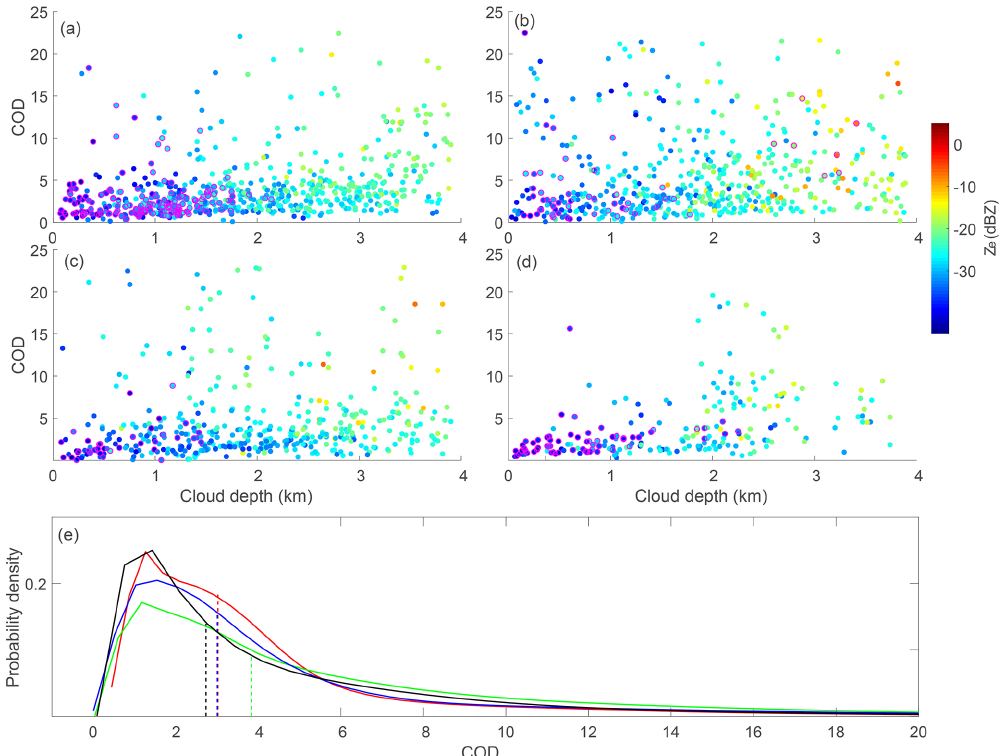
Figure 4. The cloud optical depth (COD) of ice clouds in terms of the cloud depth in spring (a) , summer (b) , autumn (c) , and winter (d) . Colors indicate the mean reflectivity of those radar profiles within 10min of the AHI (Advanced Himawari Imager) observation time. Cases with cloud-base temperatures lower than − 38 ◦ C are illustrated with purple edges. Panel (e) presents the probability density distribution of the COD in the four